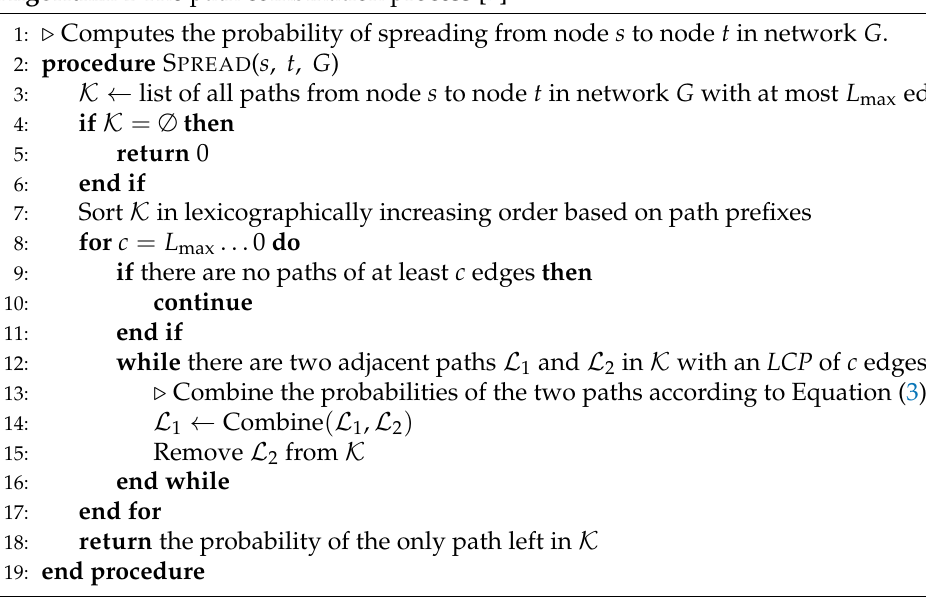
Algorithm 1 The path combination process